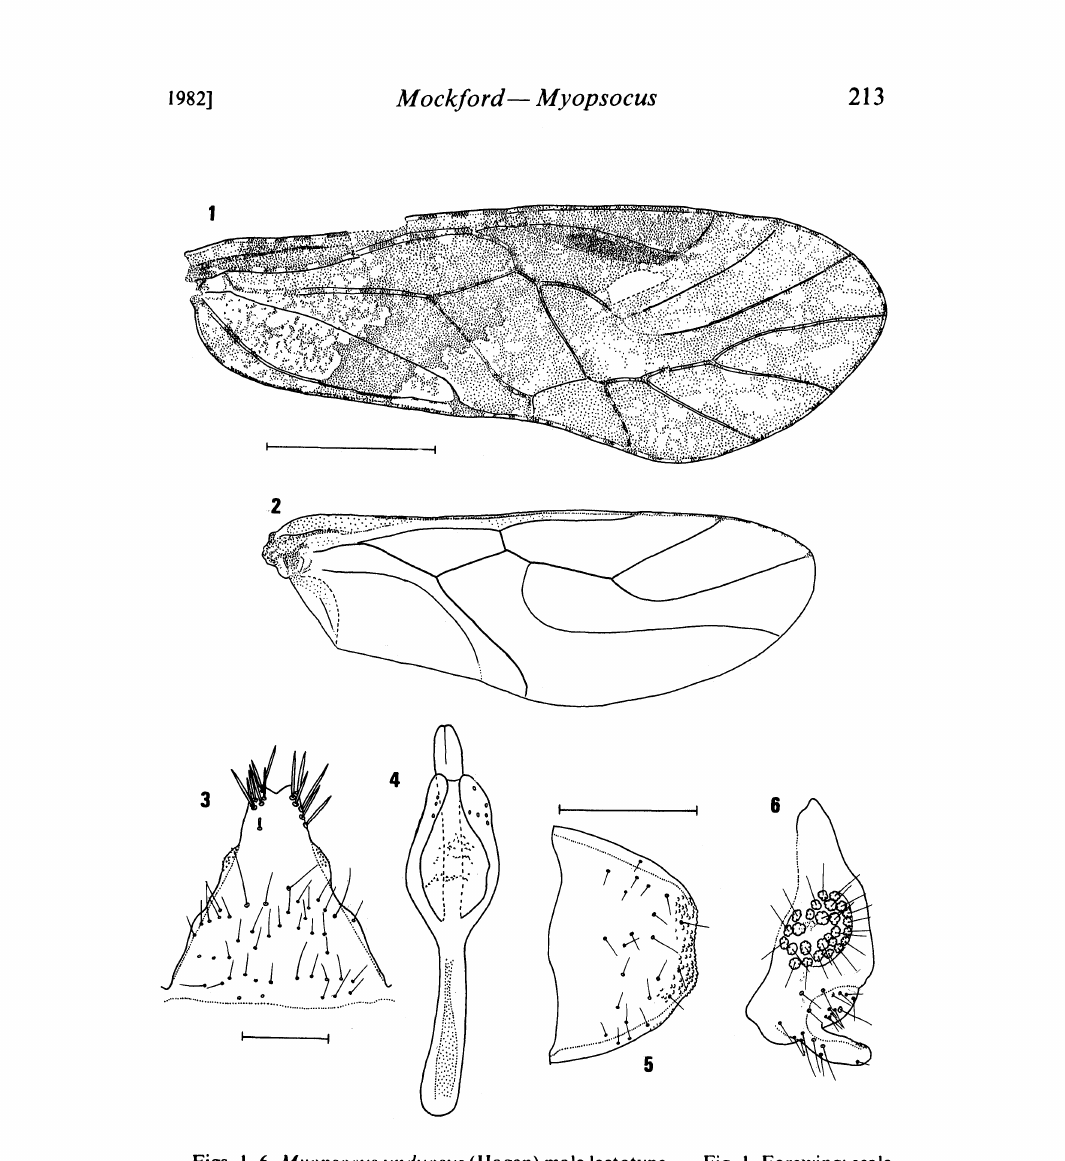
Figs. 1-6. Myopsocus unduosus (Hagen) male lectotype.. Fig. I. Forewing; scale 1.0 mm. Fig. 2. Hindwing; scale of Fig. 1. Fig. 3. Hypandrium; scale 0.2 mm. Fig. 4. Phallosome (dorsal view); scale of Fig. 3. Fig. 5. Epiproct; scale 0.2 mm. Fig. 6. Right paraproct; scale of Fig.